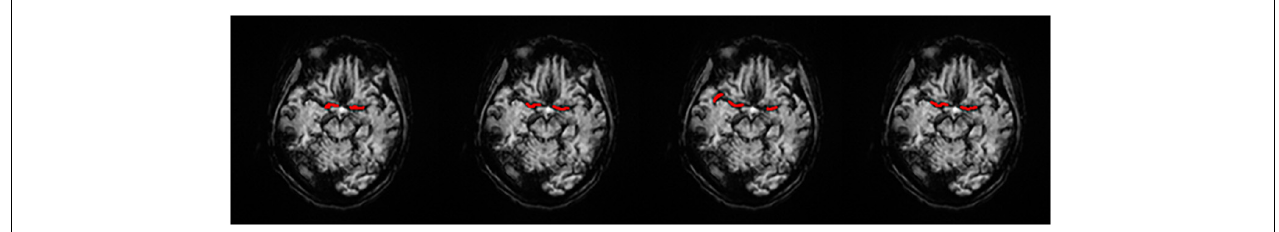
TABLE 1 | Comparison of DSC value between the automated AIF estimation methods. Methods